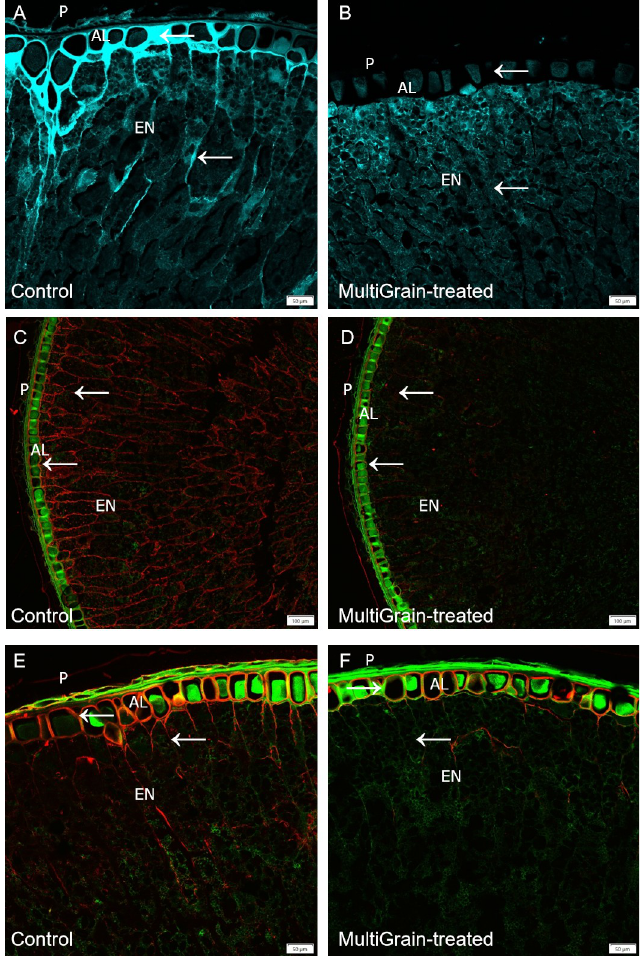
Fig 2. Confocal images of cross sections of whole wheat grains. Section of samples incubated (A, C, E) with sodium acetate buffer (control) or (B, D, F) with MultiGrain for 3 hours at pH 5. The sections were subsequently (A, B) stained with Calcoflour White, or (C, D) incubated with the LM11 antibody detecting arabinoxylans with low degree of branching and the red-fluorescence labelled secondary antibody, or (E, F) incubated with the antibody detecting (1,3), (1,4)- β -glucan and the red-fluorescence labelled secondary antibody. (A, B) Light blue signal indicates cellulose and other β -1,4-linked glucans. Red signal indicates (C, D) arabinoxylans and (E, F) β -glucans and green signal indicates autofluorescence. P = pericarp; AL = aleurone; EN = starchy endosperm. Arrows point to sites where the fluorescence signal due to staining or immunolabelling is present and removed following treatment with MultiGrain. (A, B) Scale bar = 50 μ m, (C, D) Scale bar = 100 μ m, (E, F) Scale bar = 50 μ